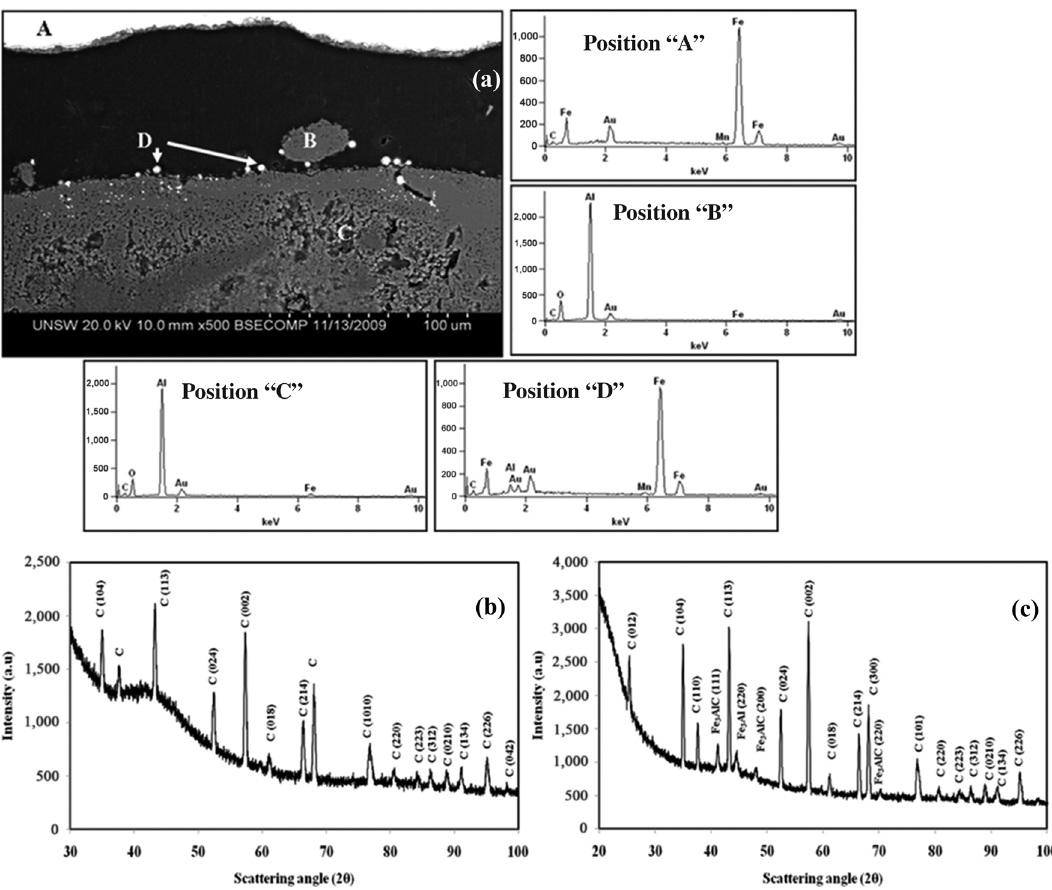
Figure 4: (a) SEM image and EDS analysis of 100% alumina sample containing 5% phenolic resin and iron at 1,823 K for 30 min, (b) XRD pattern of 100% alumina sample interacted with iron showing only alumina peaks (corundum, C) and (c) XRD pattern of 100% alumina sample interacted with 5% phenolic resin and iron at 1,823 K for 30 min using sessile drop arrangement. This pattern shows a few peaks in addition to alumina